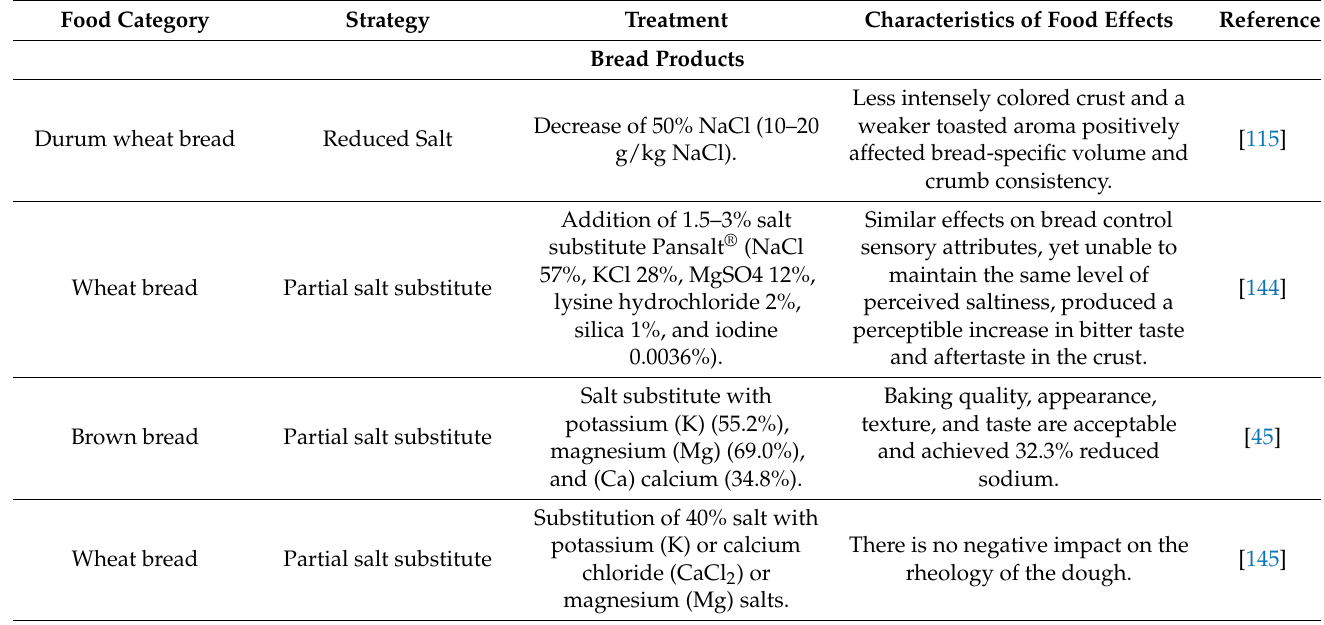
Table 1. Summary of various treatments to reduce salt levels and their impact on food